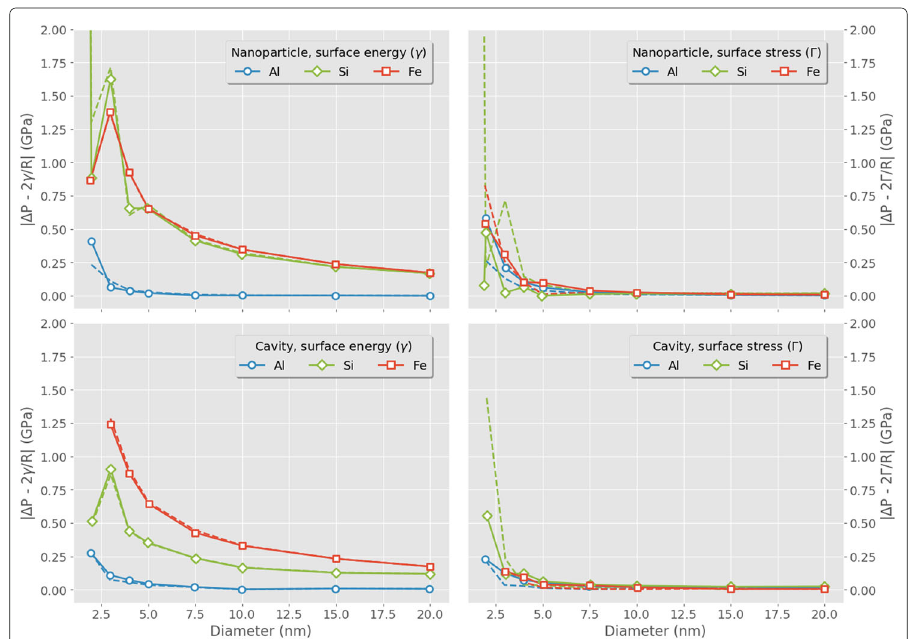
Fig. 6 Absolute difference between the pressure calculated in the nanoparticle or in the vicinity of the cavity, and the Laplace pressure as a function of the nanoparticle/cavity diameter, with no extra applied pressure. Top (bottom) graphs show results for nanoparticles (cavities). The Laplace pressure is computed using either surface energy γ (left graphs) or surface stress (cid:3) (right graphs). Full lines with symbols show results obtained with γ or (cid:3) values corresponding to each diameter, while values at diameters equal to 20 nm are used to obtain data associated with dashed lines